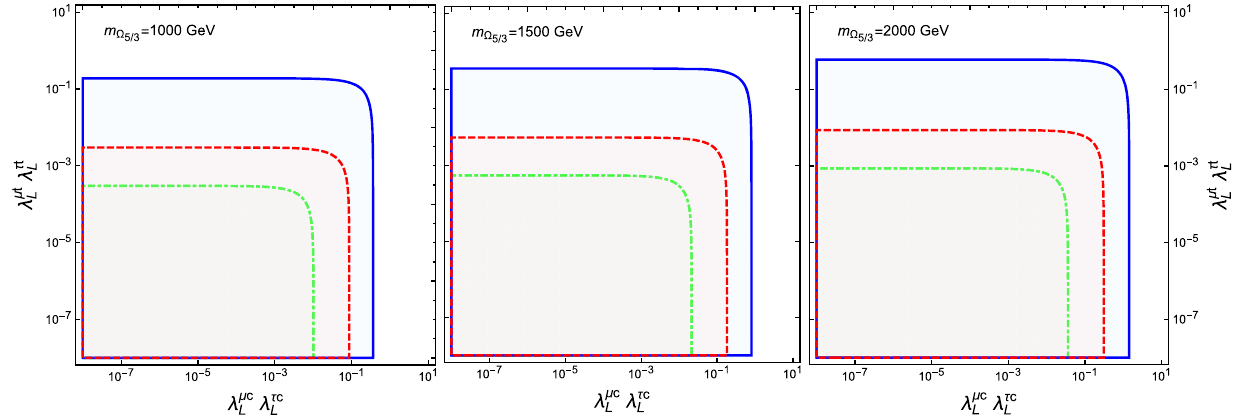
μ c μ t λ τ c λ τ t Fig. 7 Allowed area with 95% C.L. in the λ vs λ plane from the experimental bound on the τ → μγ decay for three values of m Ω L L L L (cid:3) u i /λ (cid:3) u i = O ((cid:7)) , for (cid:7) = 10 − 3 (solid-line boundary), (cid:7) = 0 . 1 (dashed-line boundary), and (cid:7) = 1 (dot-dashed-line boundary) the scenario with λ R L ¯ (cid:3)(cid:3) 6 Numerical analysis of the t → cX and t → c branching